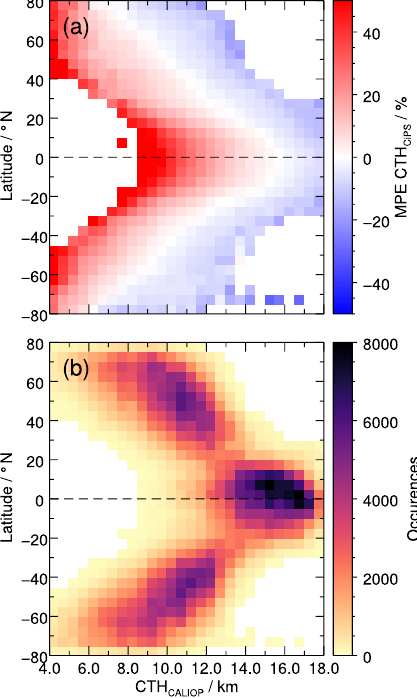
Figure 10. (a) Two-dimensional histogram showing the MPE of the CTH CiPS retrieval as a function of the reference CTH retrieval by CALIOP and the latitude. (b) The corresponding occurrences of the points that make up the statistics shown in (a)